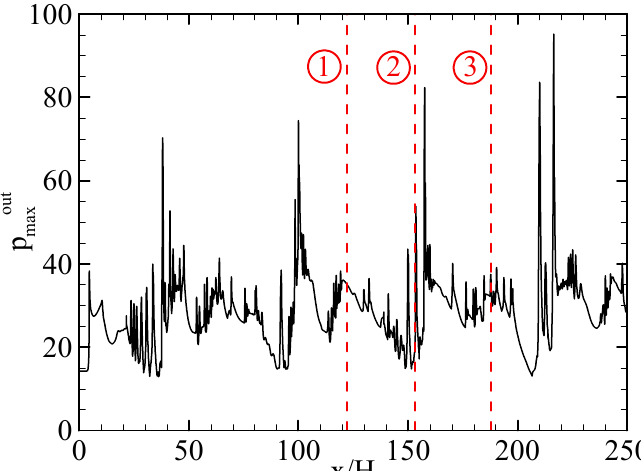
Figure 12. Pressure variation along the outer wall from the numerical analysis of tri-arc RDE.